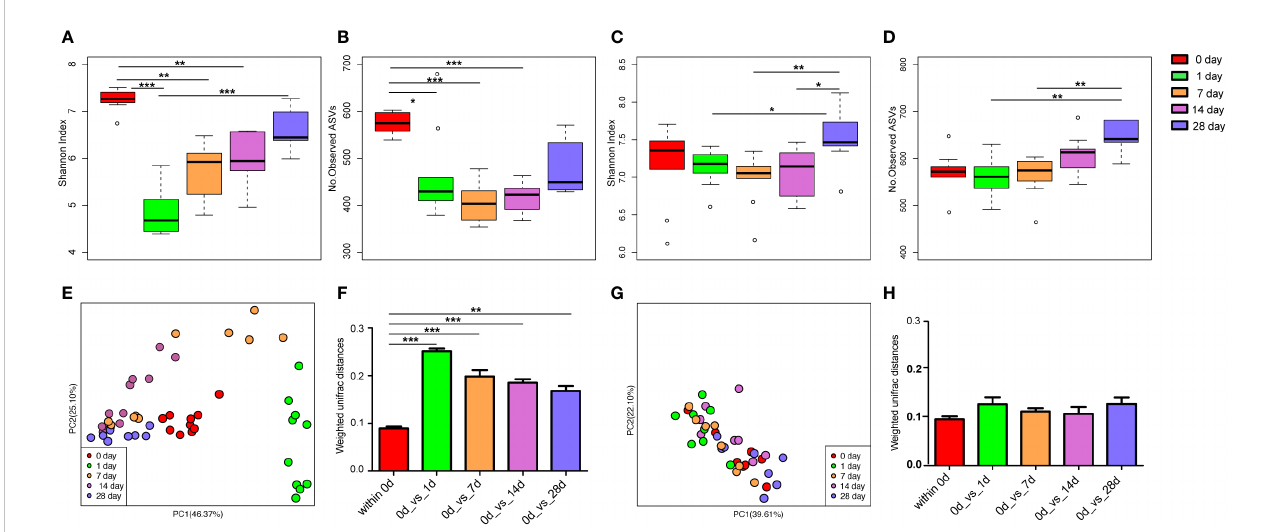
FIGURE 2 Dynamic changes of alpha and beta diversity of gut microbiotas in Escherichia coli (LD50) infection model mice treated with antibiotics and geraniol. Shannon index (A) and number of observed ASVs (B) of gut microbiotas in bacterial infection model mice treated with antibiotics; Shannon index (C) and number of observed ASVs (D) of gut microbiotas in bacterial infection model mice treated with geraniol; Principal coordinate analysis (PCoA) based on Weighted Unifrac distance in antibiotic treatment group (E) and geraniol treatment group (G) ; Dynamic changes of phylogenetic distance of gut microbiotas of mice after administration of antibiotics (F) /geraniol (H) and before administration. 0th day indicates that the mice are infected with E coli and have not been treated with drugs; 1st day means 1 day after injection drug; 5th day means 5 days after continuous injection drug, and stopping administration; 14th and 28th day mean 14, 28 days after administration, separately. (p values calculated by the One-way ANOVA test followed by post- hoc Dunn ’ s multiple comparisons test: ∗ < 0.05, ∗∗ < 0.01 and ∗∗∗ <